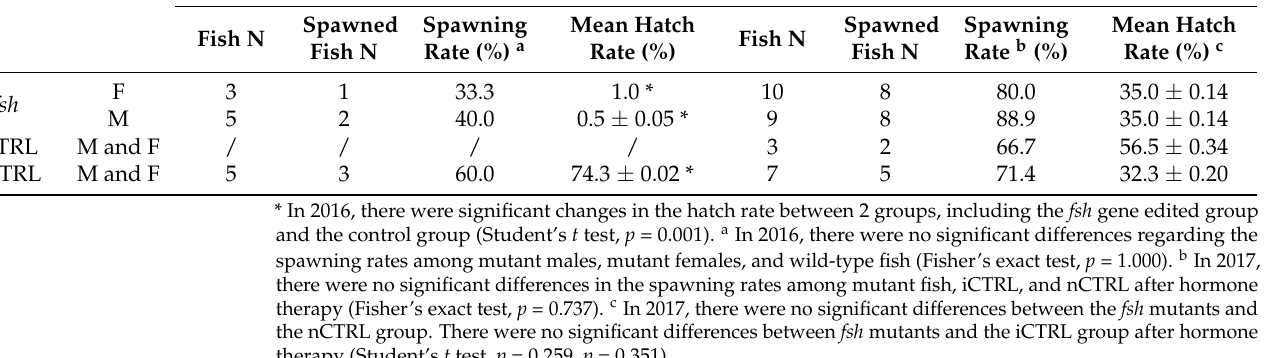
* Mutant fish in the family 2017 FSH ‐ 3 had a considerably lower body weight (Student’s t test, p = 0.009) than non ‐ mutant fish in the same family. a The mutant fish and non ‐ mutant fish had no sig ‐ nificant differences in body weight in seven F 1 families, including 2016 FSH ( p = 0.807), 2017 FSH ‐ 1 ( p = 0.827), 2017 FSH ‐ 2 ( p = 0.156), 2017 FSH ‐ 4 ( p = 0.585), 2017 FSH ‐ 5 ( p = 0.373), 2017 FSH ‐ 6 ( p = 0.223), and 2017 FSH ‐ 7 ( p = 0.578) (Student’s t test). b Mutation rate was not significantly different ( p